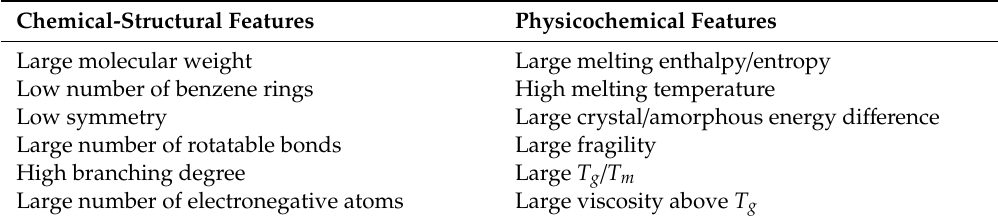
Table 1. Features of good glass formers based on small organic molecules.